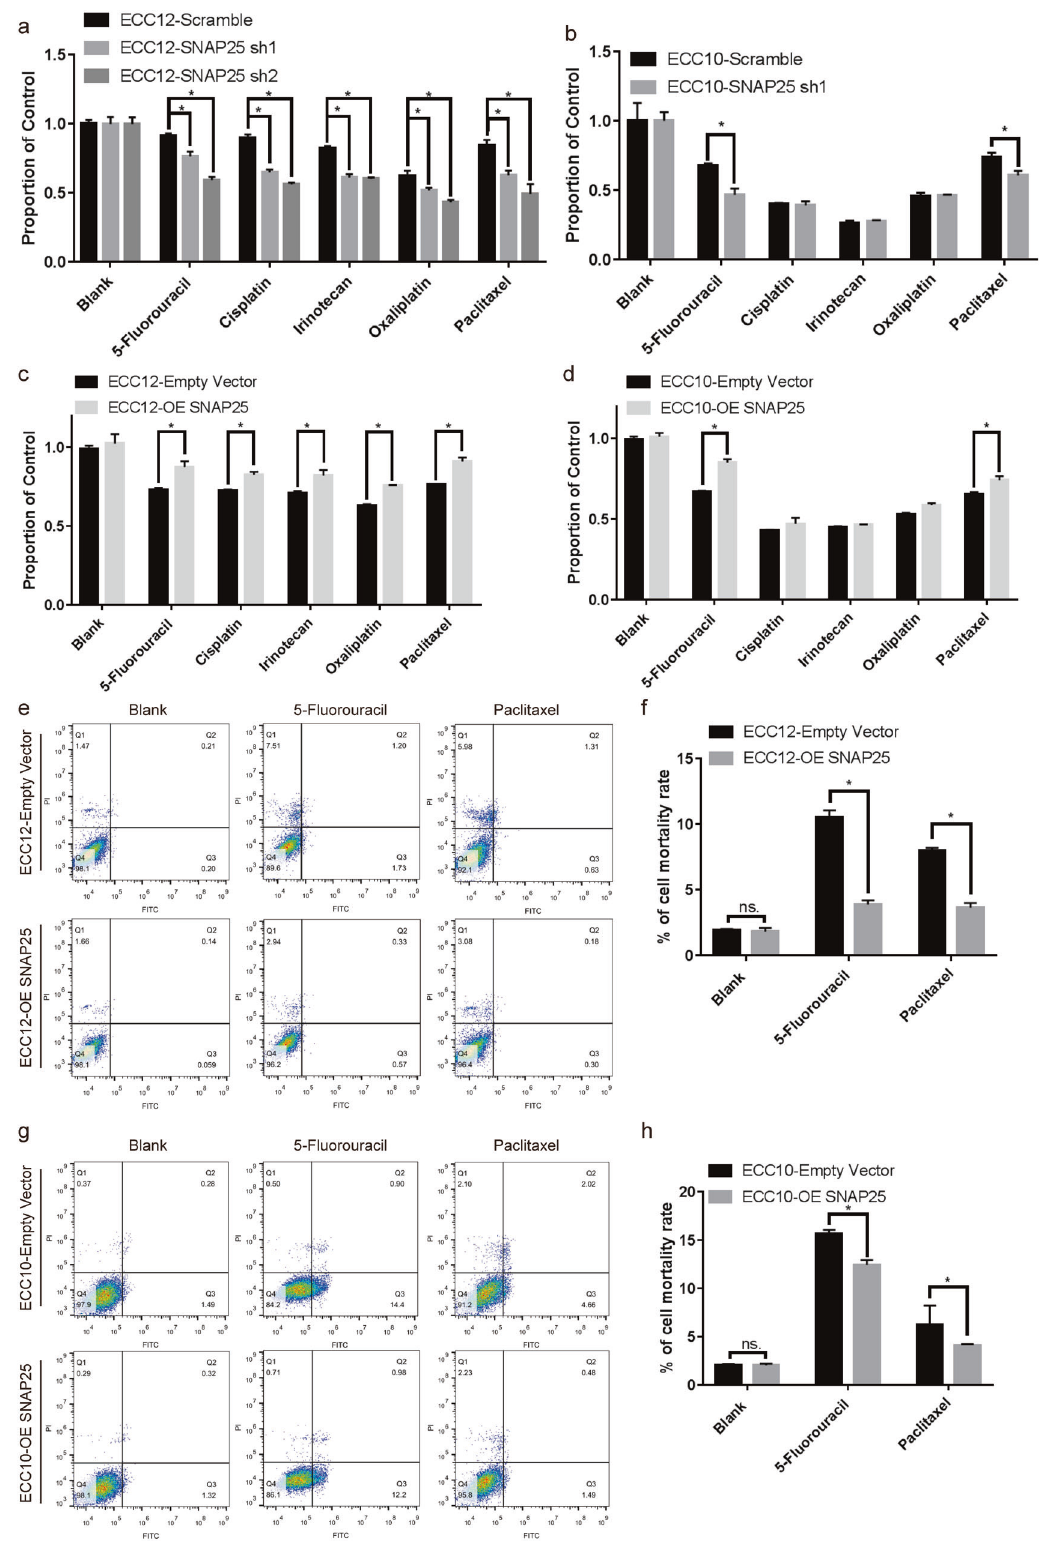
Fig. 4 SNAP25 affects resistance to multiple drugs in GNEC cells. a – d Cell viability determination after treatment with multiple chemotherapy drugs in SNAP25 knockdown and overexpression GNEC cell lines. e – h Cell apoptosis detection after 5- fl uorouracil and paclitaxel treatment in SNAP25 knockdown and overexpression GNEC cell lines. Plots indicate the average ± s.d. Signi fi cance test is indicated *( p < 0.05).